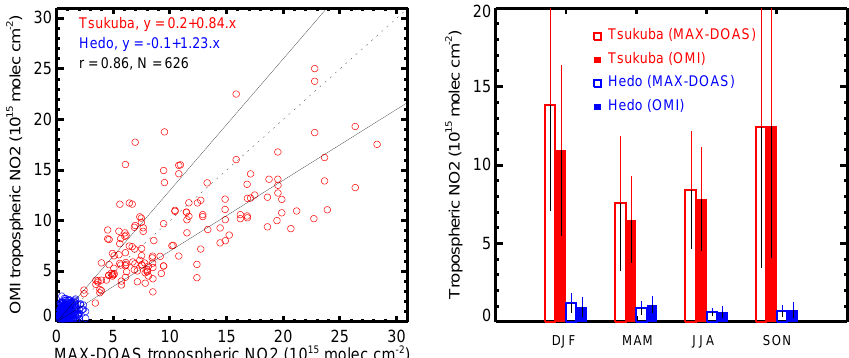
Figure 10. Comparison of tropospheric NO 2 columns retrieved from OMI and MAX-DOAS instruments. Observations at Tsukuba and Hedo, Japan, are shown in red and blue, respectively. (left) Scatter plot of OMI tropospheric NO 2 and MAX-DOAS measurements. The regression analysis parameters are given in the legend. The slope was calculated with reduced major-axis linear regression (Hirsch and Gilroy, 1984). The dotted line represents the 1:1 relationship and the solid lines represent the 30% deviation range. (right) Seasonal mean tropospheric NO 2 columns for December–February (DJF), March–May (MAM), June–August (JJA), and September–November (SON) for 2006–2011 from MAX-DOAS (open bars) and OMI (filled bars). The vertical lines are the standard deviation of the seasonal average.